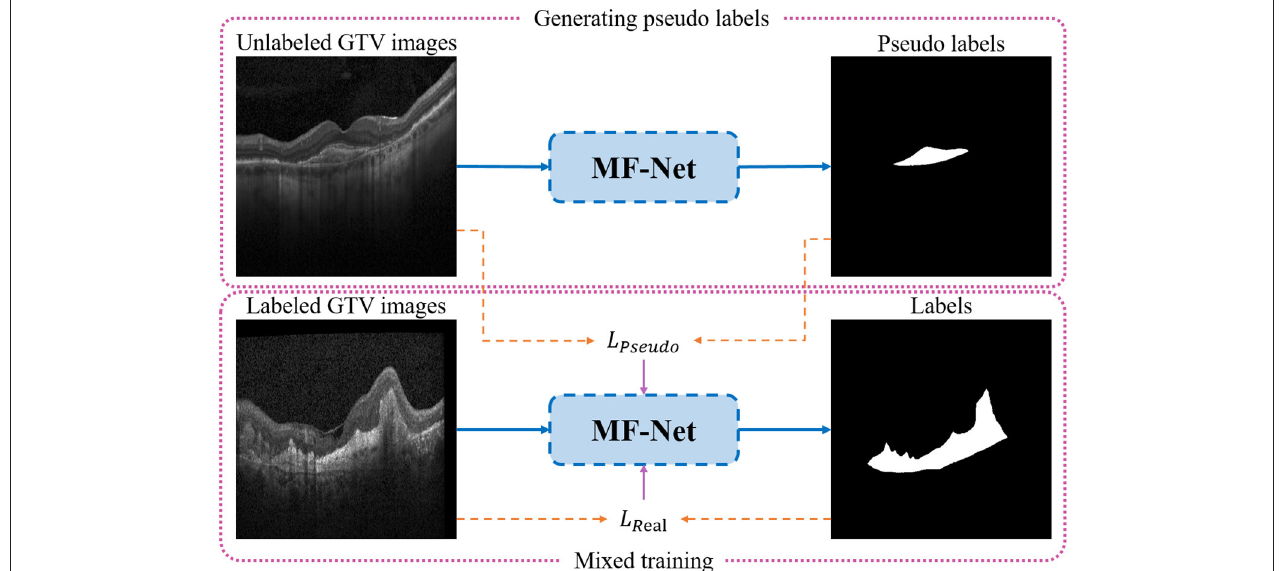
FIGURE 4 | Architecture of the proposed